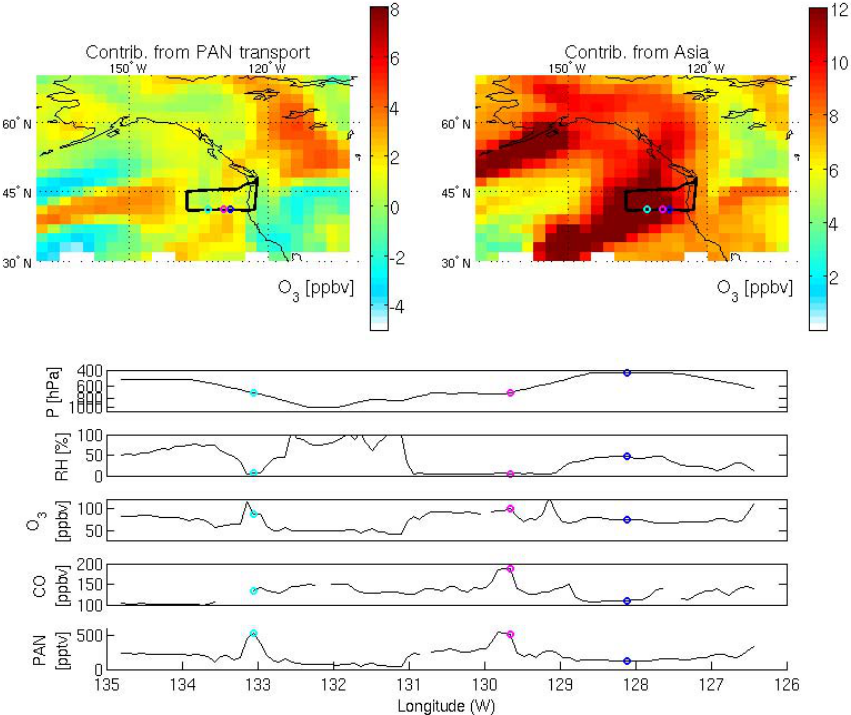
Fig. 15. Detail of the C-130 during the May 5, 2006 transport event. The left panel shows the flight track of the C-130 on May 5, 2006 overlaid on the simulated contribution to ozone concentrations due to transport of PANs at 4km. The top right panel displays the flight track atop the contribution from Asian emissions. The bottom plots show aircraft measurements during the westbound leg where the aircraft encounters a plume of elevated O 3 , CO, and PANs at about 700hPa. Blue, magenta, and cyan circles mark the location of the aircraft on the maps during the data series.